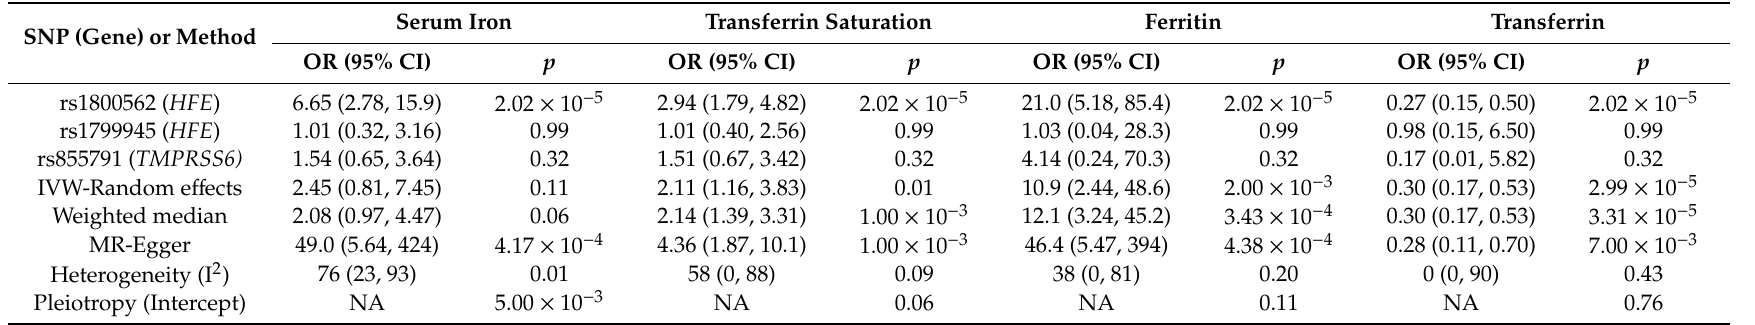
Table 3. Associations between genetically predicted iron status, based on three primary SNPs, and liver cancer in sensitivity analyses. SNP (Gene) or Method